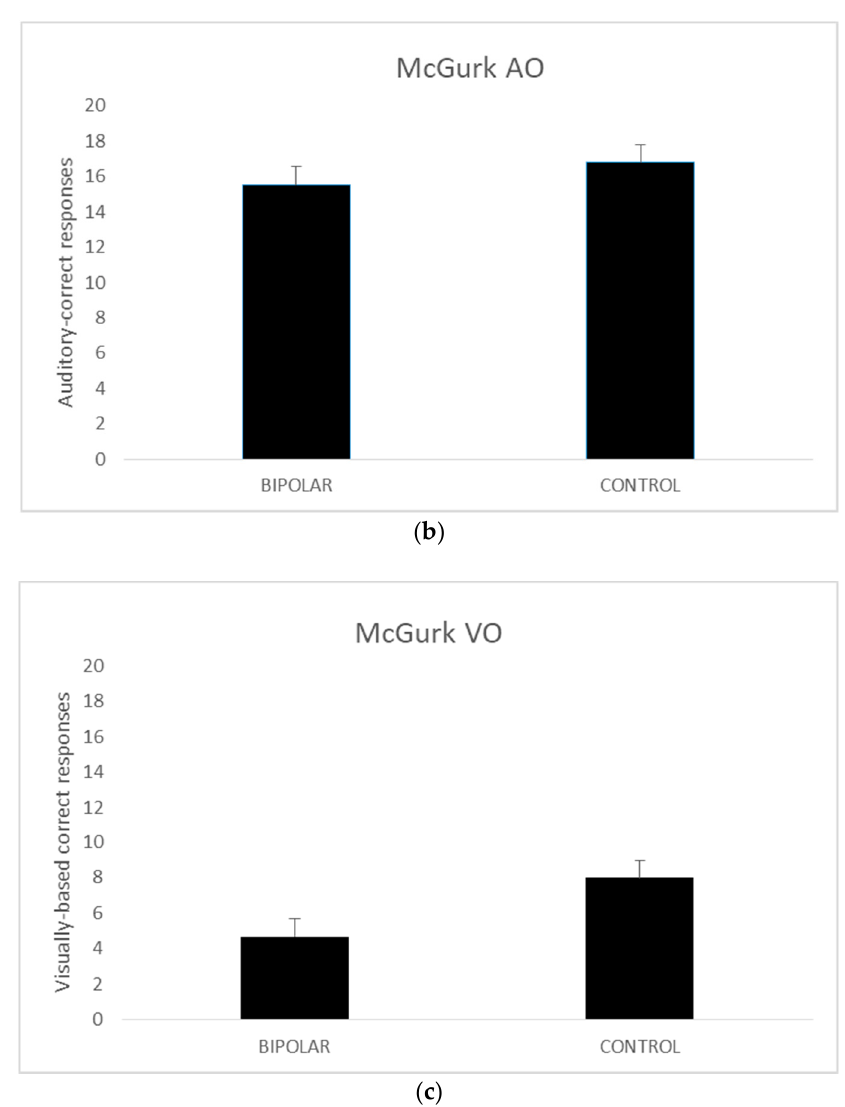
Figure 1. The mean scores of auditory–visual (AV; ( a )), auditory-only (AO; ( b )), and visual-only (VO; ( c )) scores obtained from the bipolar groups combined and the control group. Error bars represent the standard error of the mean.